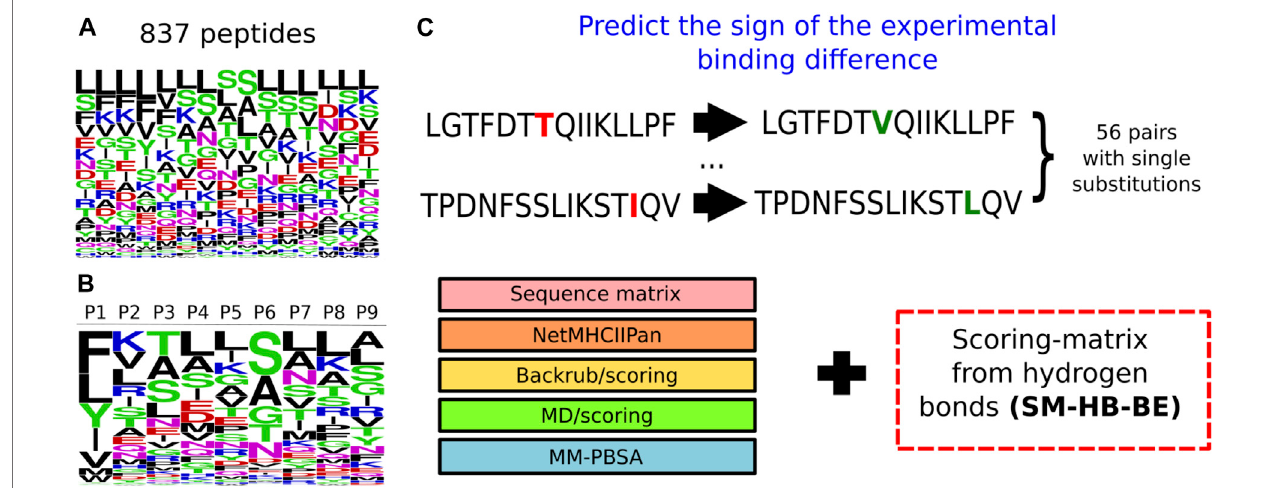
FIGURE 3 | Information used to model peptides bound to the structure of the MHC class II allele DRB1*0101. (A) Logo representing the frequency of the amino acids within the 837 15-mer peptides that were modelled bound to the MHC class II structure. The larger the height of the letter the more relevant the amino acid is for improvingbinding. (B) Logorepresentingtheprobabilityoftheaminoacidsateachpositionofthecoreregionbasedonthenumberofhydrogenbondsmadebythemain chain. The colors represent categories of the amino acids based on physicochemical properties: blue (positive charged), red (negative charged), green (small), fucsia (asparagine) and black (aliphatic). (C) Prediction of the sign of the experimental binding differences, for a set of 56 peptides with single substitutions, using the scoring-matrix (SM-HB-BE) in combination with the state-of-the-art methodologies.